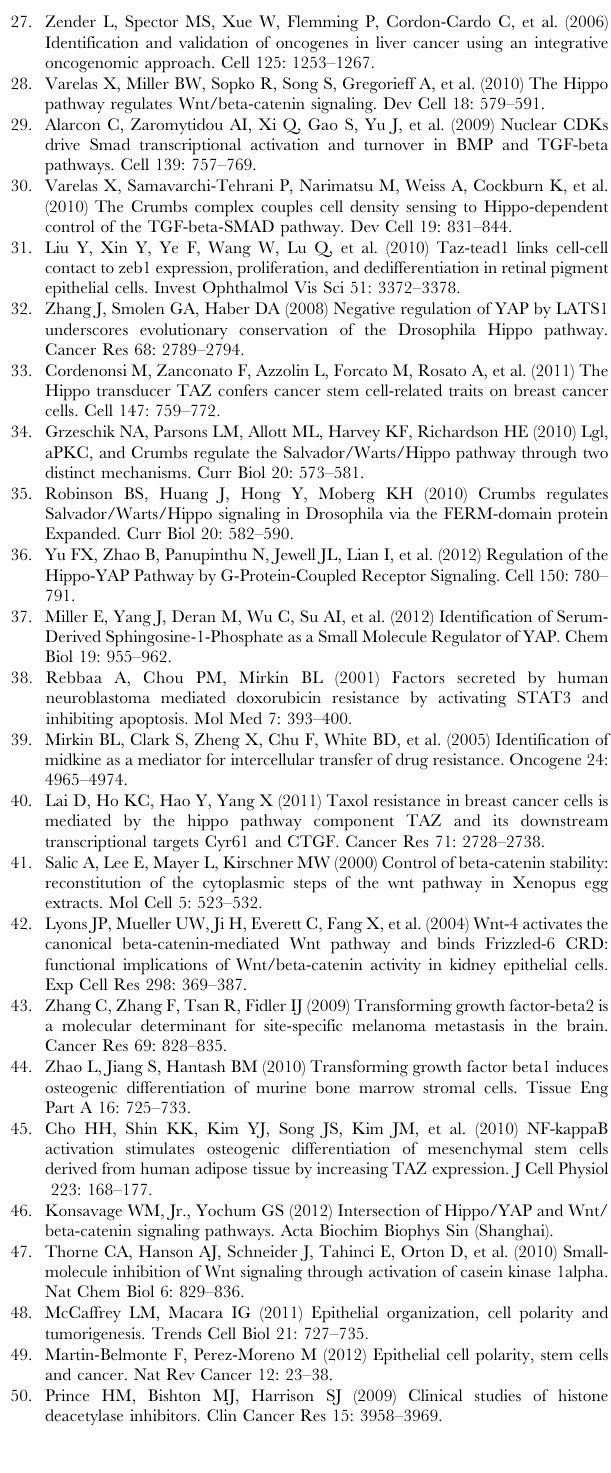
Figure 1D. The band intensity was quantified using ImageJ software (NIH). The data represent average of three determina- tions 6 SE. Significance reflects comparison between Belinostat- treated cells and the corresponding non-treated cells (*p , 0.05, **p ,